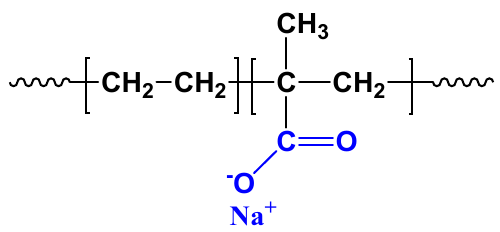
/ methacrylic acid (EMAA) copolymer Scheme 1. Chemical structure of ethylene/methacrylic acid (EMAA) copolymer (Surlyn). Scheme 1. Chemical structure of ethylene